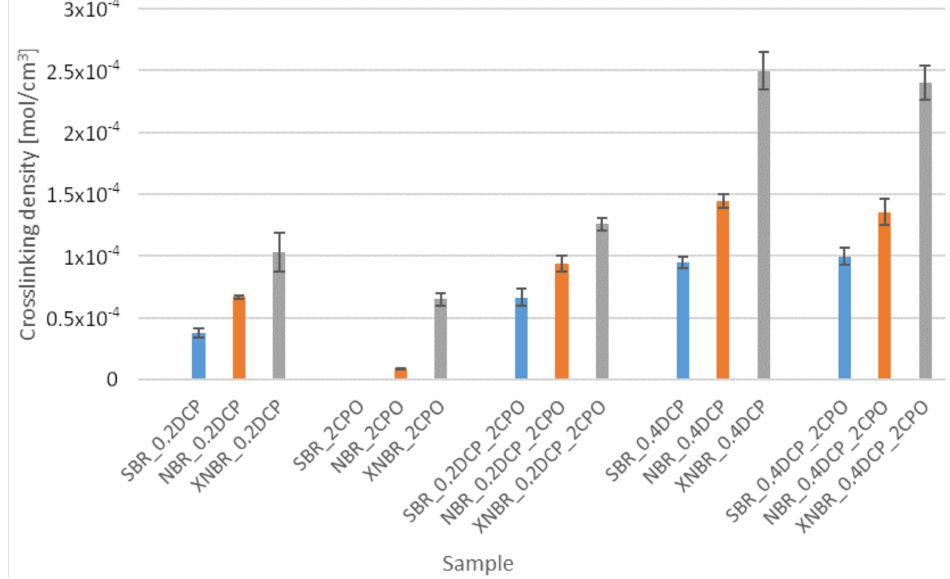
Figure 2. Influence of the carboxy-containing peroxy oligomer (CPO) addition on the crosslink density of the rubbers